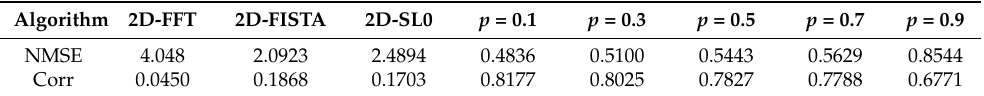
Figure 3. MIMO imaging results with 2D-FFT, 2D-FISTA, 2D-SL0, and the proposed algorithm with p = 0.1, p = 0.3, p = 0.5, p = 0.7, and p = 0.9. Table 2. Imaging